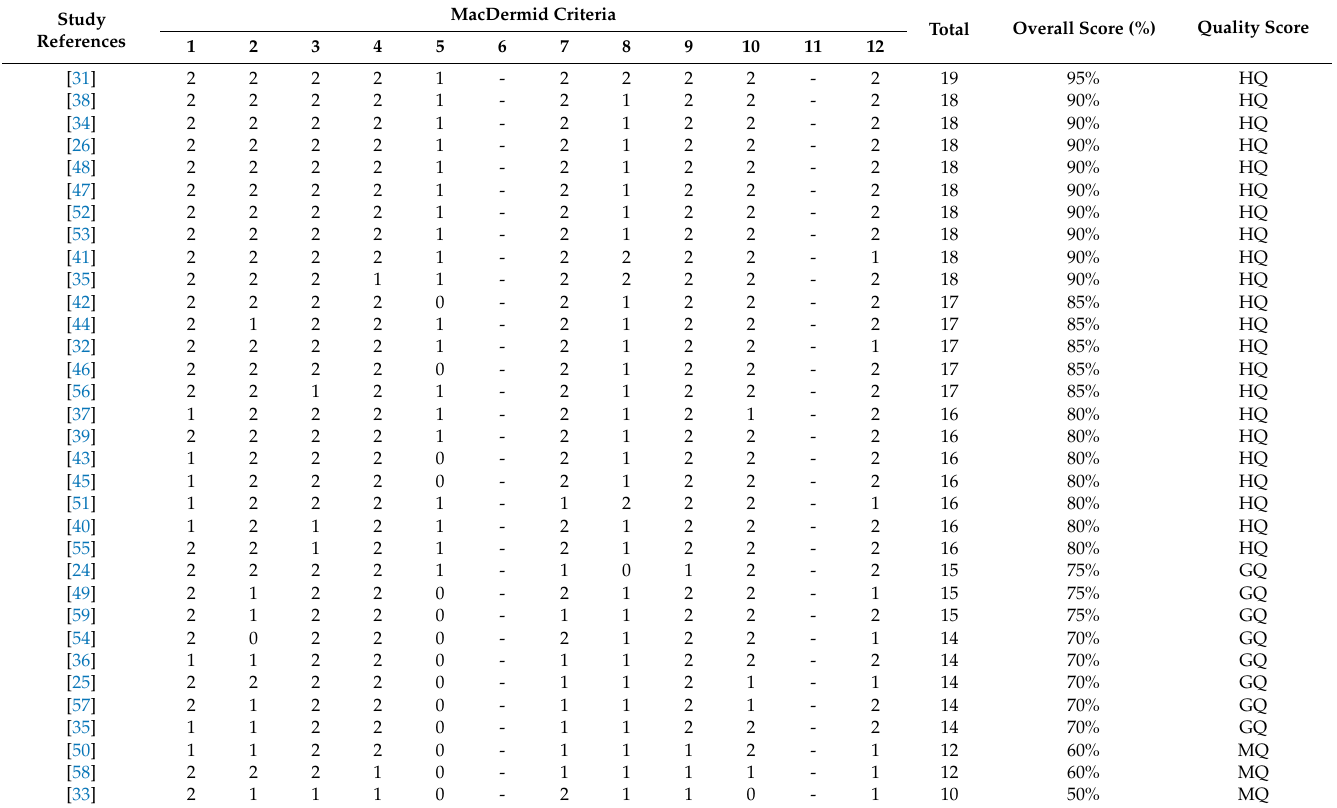
Table 5. Summary of methodological quality appraisal of included studies using MacDermid